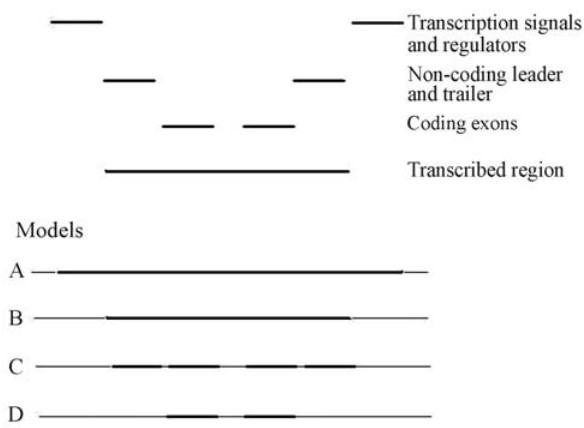
Figure 1 - Four structural models for the protein-coding gene (Fogle, 1990). The solid lines represent areas included in each